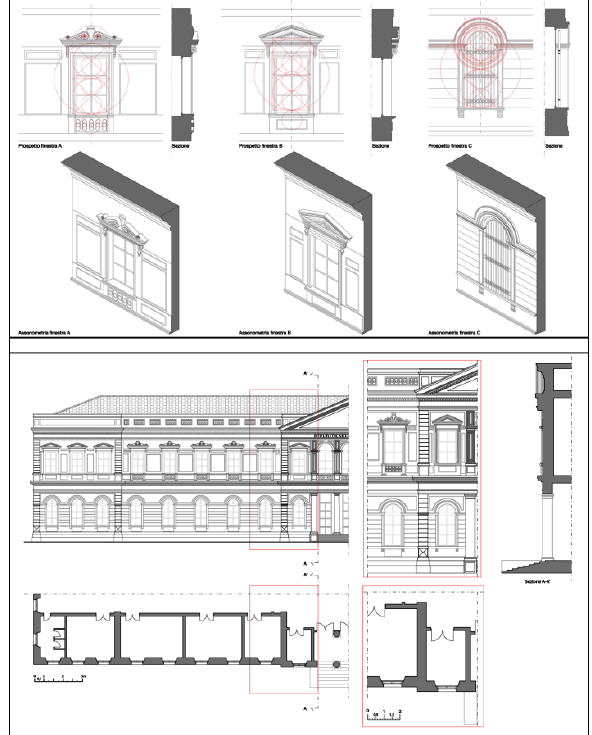
Figure 5 Windows’ abacus, synthesis of proportional and modular study of the decorative system. Front elevation and